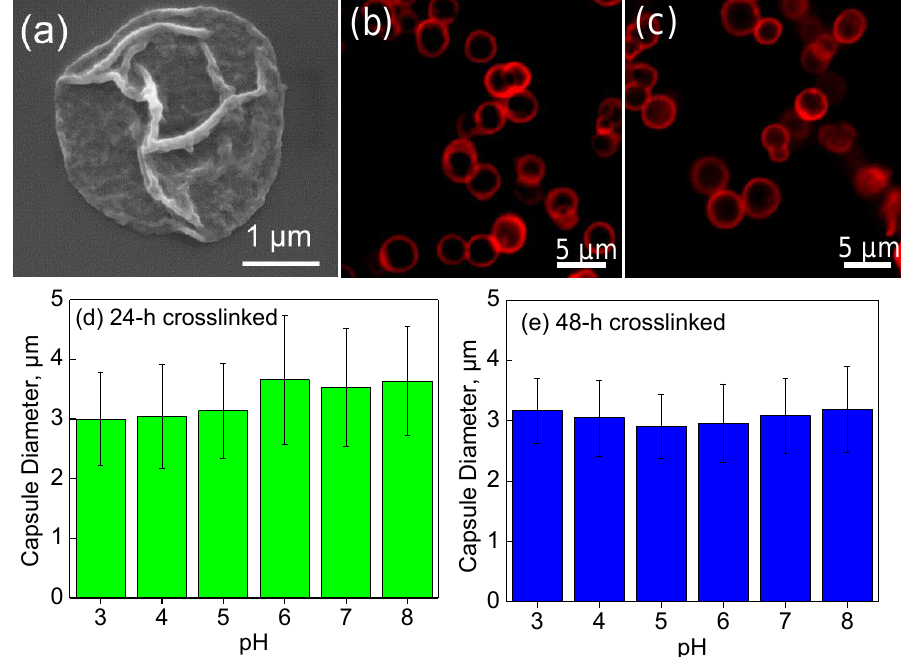
Figure 2. ( a ) SEM image of (PMAA/PVPON) 13 multilayer hydrogel capsules. CLSM images of (PMAA/PVPON) 6 hydrogel capsules crosslinked for ( b ) 24 h and ( c ) 48 h imaged in solution at pH 4. Average diameters of the capsules crosslinked for 24 ( d ) and 48 ( e ) hours as a function of pH as obtained from analysis of their CLSM images using ImageJ software (version 1.52e, NIH, Bethesda, MD, USA). The data is presented as mean ± standard deviation (SD). For each measurement series, at least 30 capsules were analyzed for each pH value.